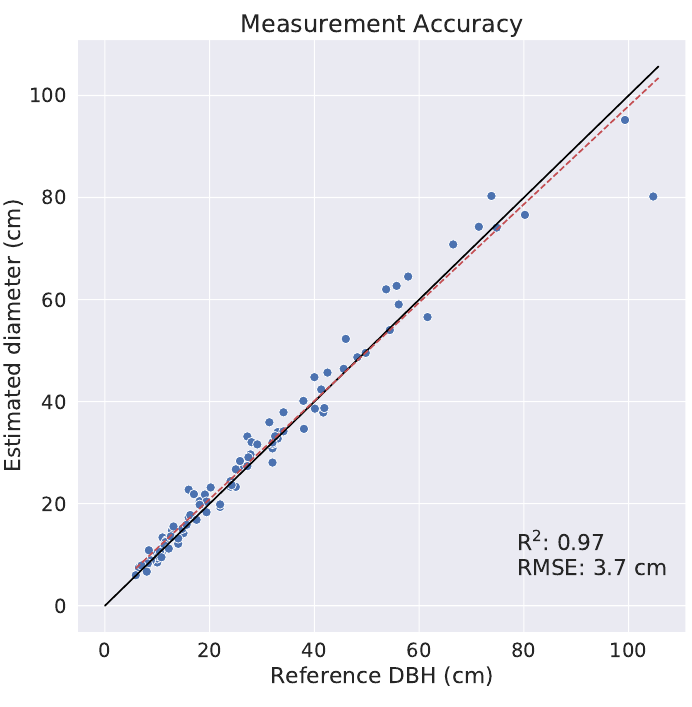
Figure 4. DBH measurements are in good agreement with app diameter estimates ( R 2 = 0.97). The red dashed line shows a linear fit to the data, and the black line shows perfect correlation (reference DBH = estimated